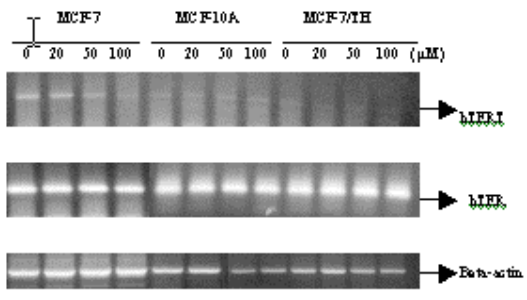
Fig. 4. hTERT and hTER expression in curcumin treated human mammary epithelial and breast carcinoma